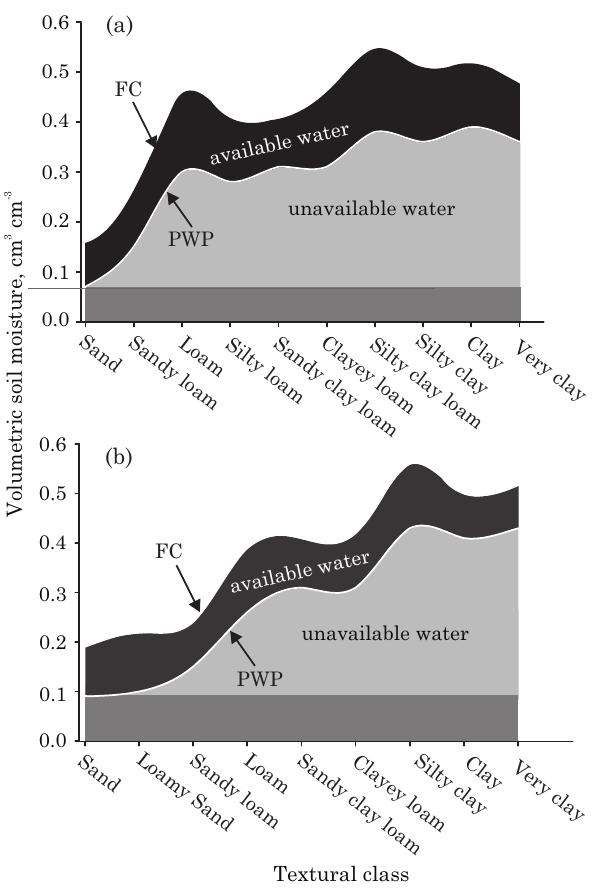
Figure 2. Variation of field capacity (FC), permanent wilting point (PWP) and available water content (AW) according to the textural class of surface (a) and subsurface (b) horizons of the soils of the State of Santa